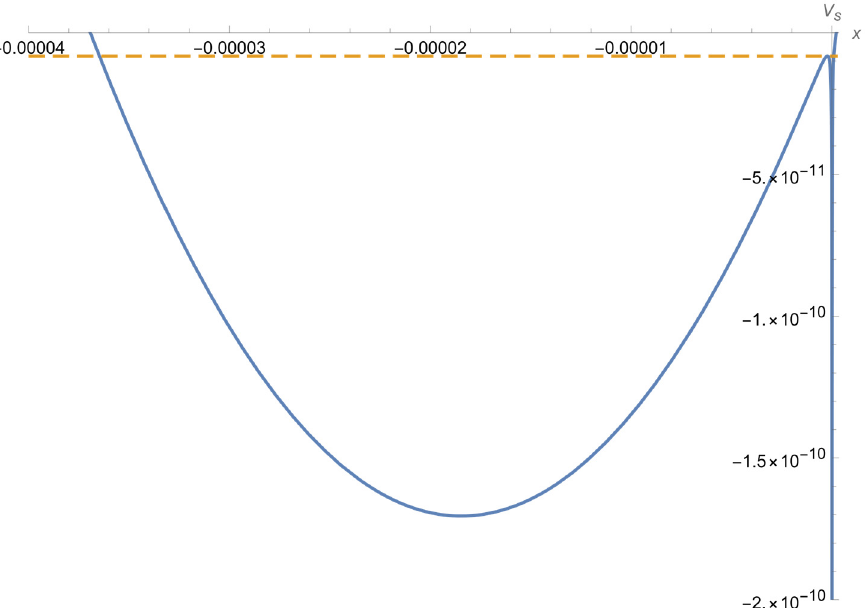
Figure 1. The dependence of scaled potential energy V s from Equation (21) on the coordinate x (in cm) for b = 1.04 × 10 9 (corresponding to B = 40,000 Tesla) and k = 19,200 corresponding to K = 60 a.u. (solid line). The dashed line corresponds to the energy at the top of the potential barrier.